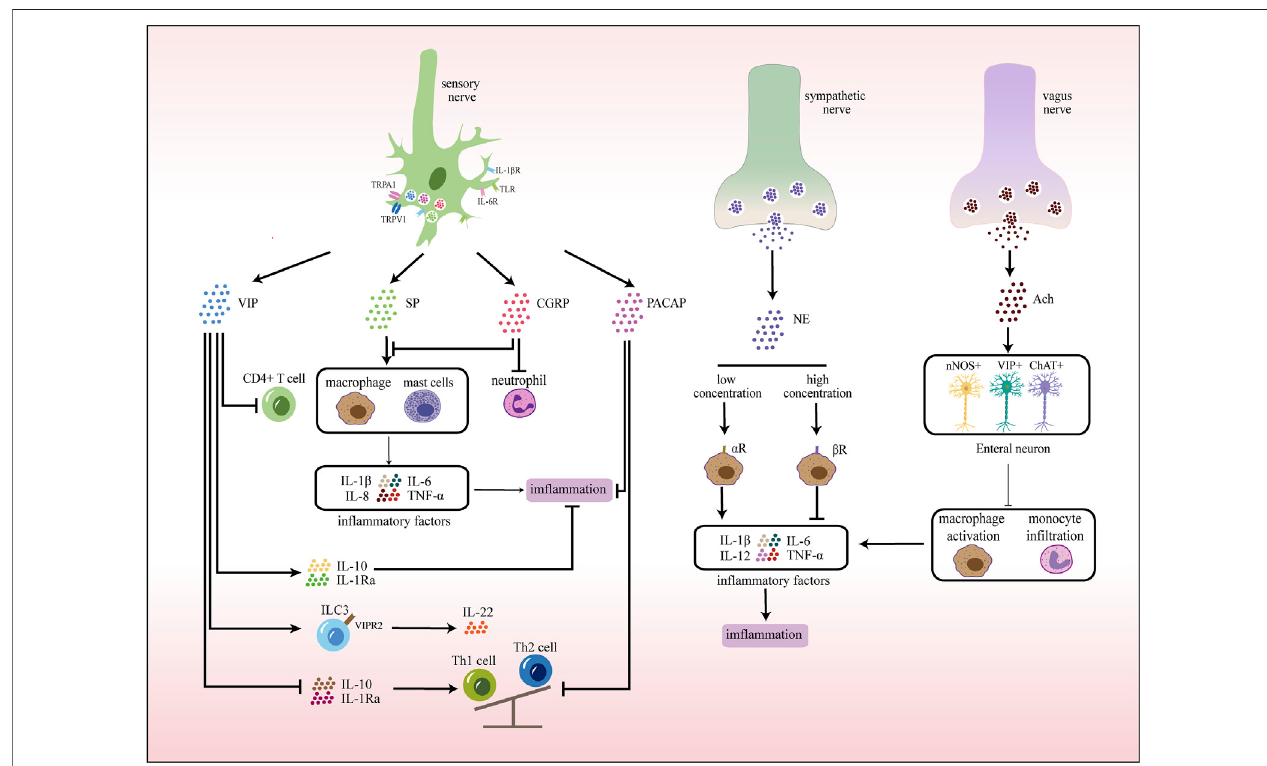
FIGURE 3 | Neuroimmune communication in the intestinal tract. In the gut, sensory nerves express receptors that recognize various stimuli, pathogens, and cytokines. Activated sensory nerves release different neurotransmitters that interact with immune cells. In addition, exogenous sympathetic and vagus nerves also participate in in fl ammatory responses by releasing corresponding